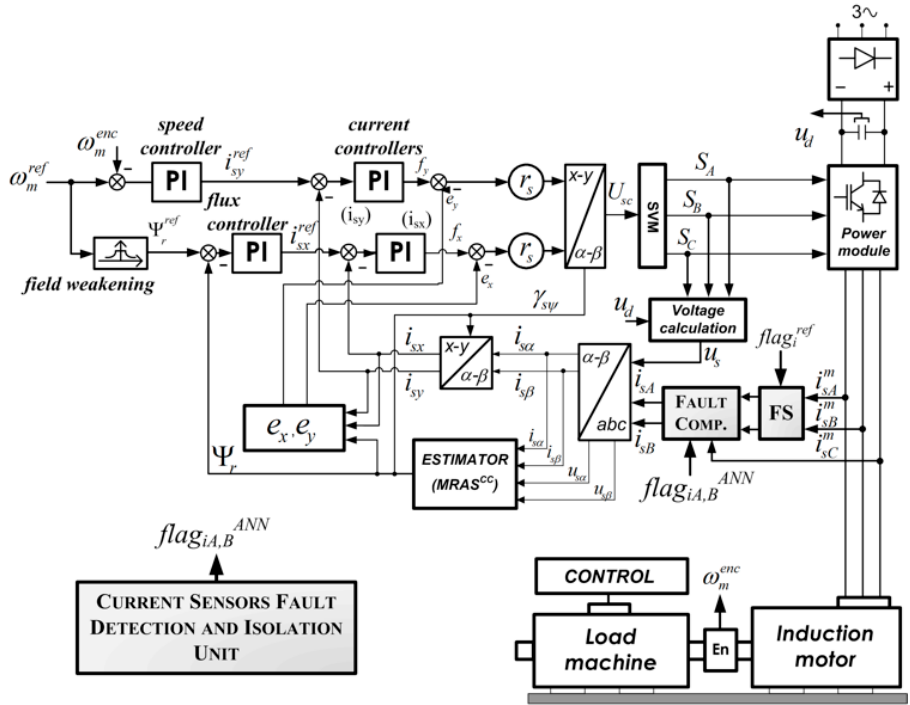
Figure 8. Scheme of the Direct Field Oriented Control (DFOC) structure with current sensor fault detection algorithm.